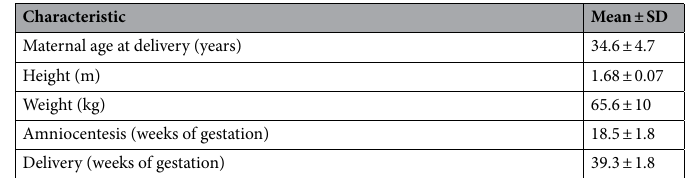
Table 2. Characteristics of the study population (n = 17). All 17 infants were karyotypically normal on amniocentesis and healthy at birth with normal birth